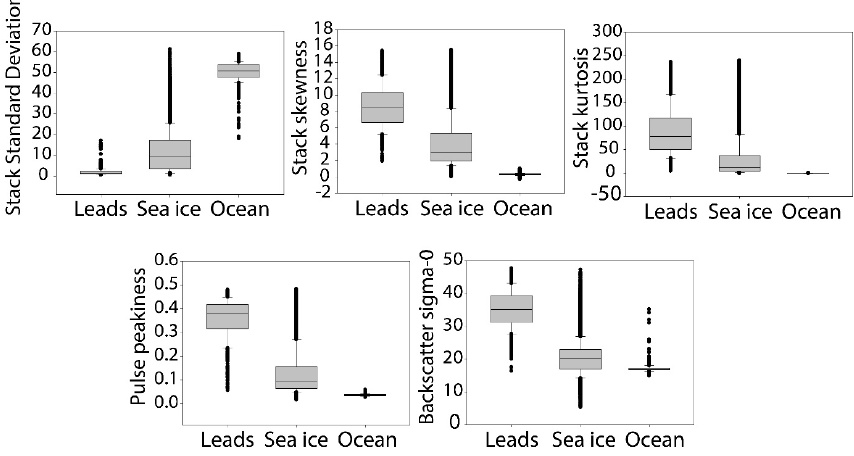
Figure 6. Box plots of five parameters (i.e., SSD, stack skewness, stack kurtosis, PP and backscatter sigma-0) over leads, sea ice and ocean using the March and April samples from 2011–2014. The vertical height of the boxes indicates the interquartile range of the samples. While a parallel line inside the boxes means a median value of the samples for each parameter, the dots represent the outliers. Table 3. Reference data used in the machine learning models by scheme and target feature. CM, Classification of Monthly data; CA, Classification of Annual data; IC, Individual Classification. Scheme Target Feature (Number of